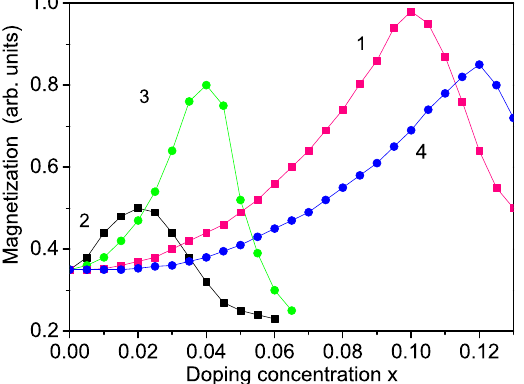
Figure 3. Ion-doping concentration dependence of the magnetization M s for Fe (1), Al (2), La (3) and Co-doped (4) MgO NPs ( T = 315 K, d = 20